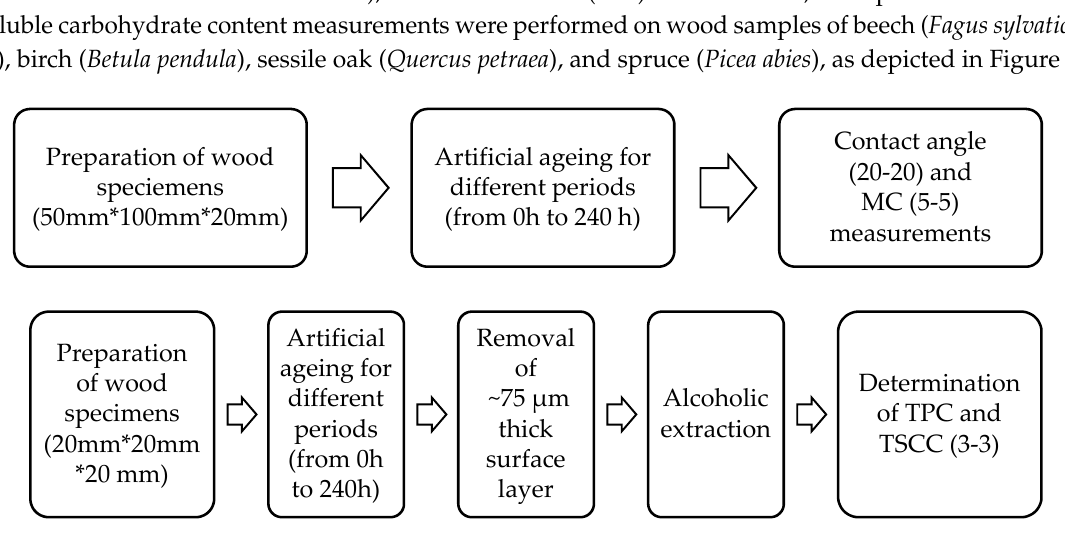
Figure 1. Flow diagram of experimental procedures.